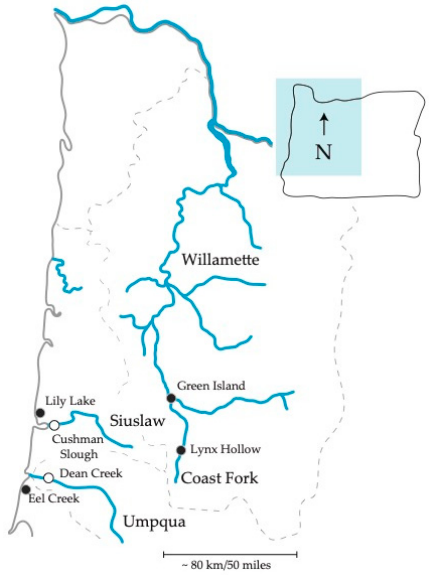
Table 1. Sample collection details for sites along the coast and inland in Oregon.